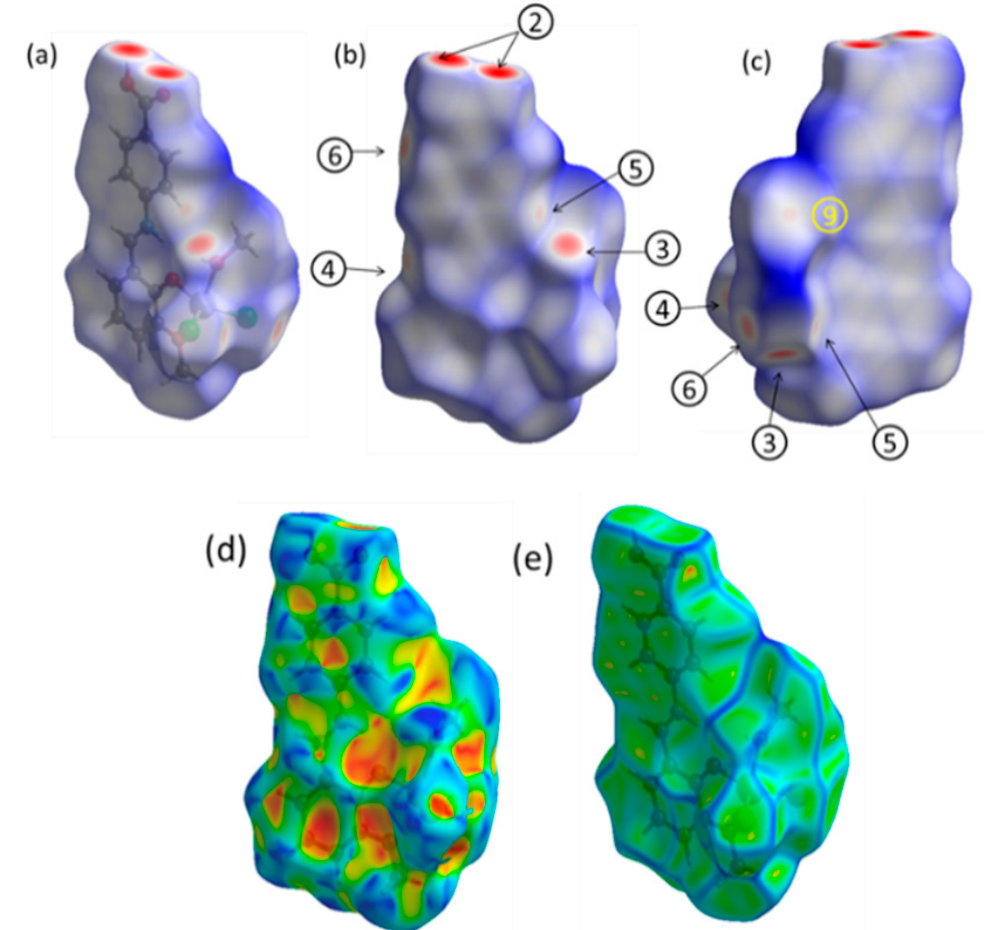
Figure 7. Representation of ( a ) Transparent for better visualization, ( b ) Front ( c ) back view of Hirshfeld surface mapped over d norm in the color range from 0.758 to 1.742. ( d ) shape index ( e ) curvedness of complex 1 . Labels are referring to Table 2 and label 9 is referred to in the comment.